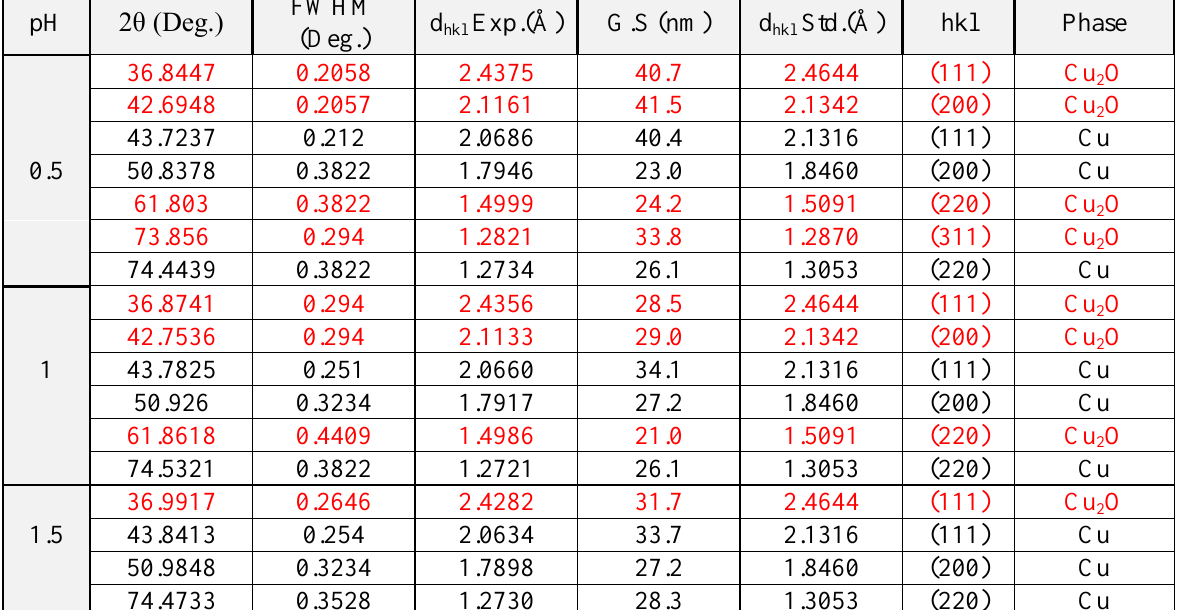
electrolyte at different 4